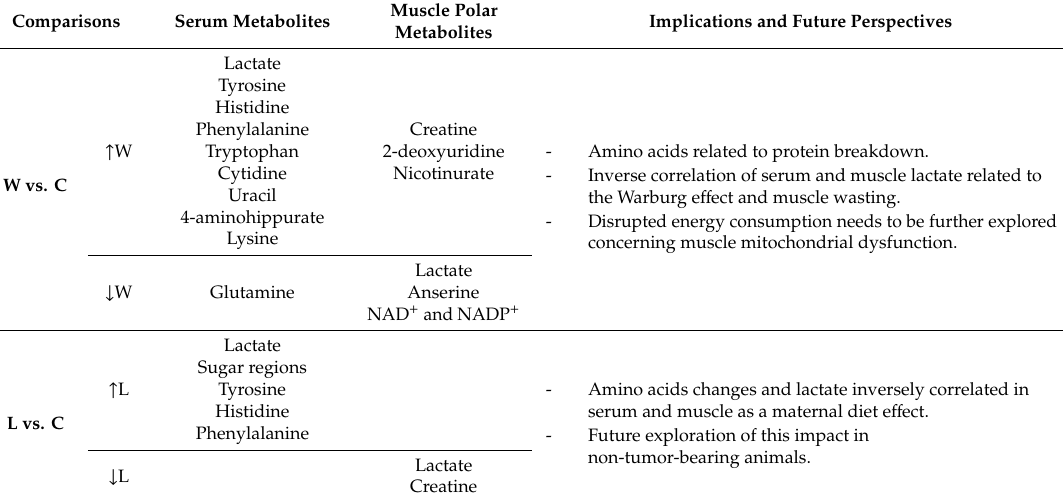
Table 2. Summarized results and future perspectives of the di ff erences found in serum and gastrocnemius muscle polar metabolites in all experimental groups, showing the maternal leucine supplementation